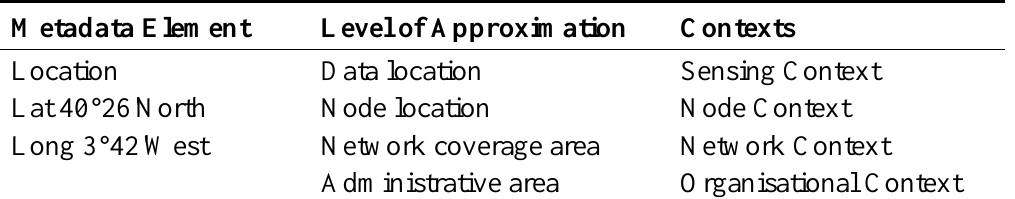
Table 4. Example of contexts according to different levels of